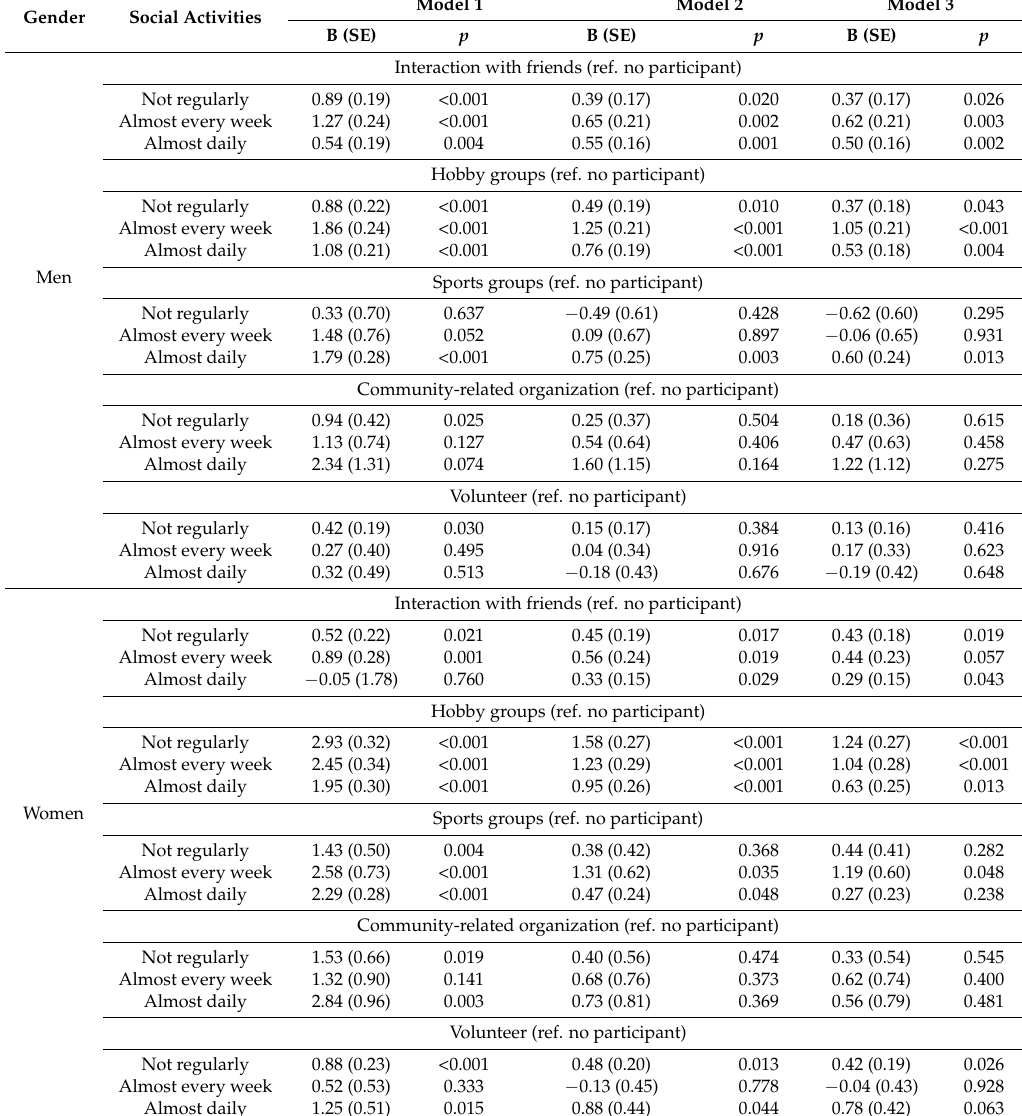
Table 3. Multiple linear regression model testing the association between social activities and cognitive